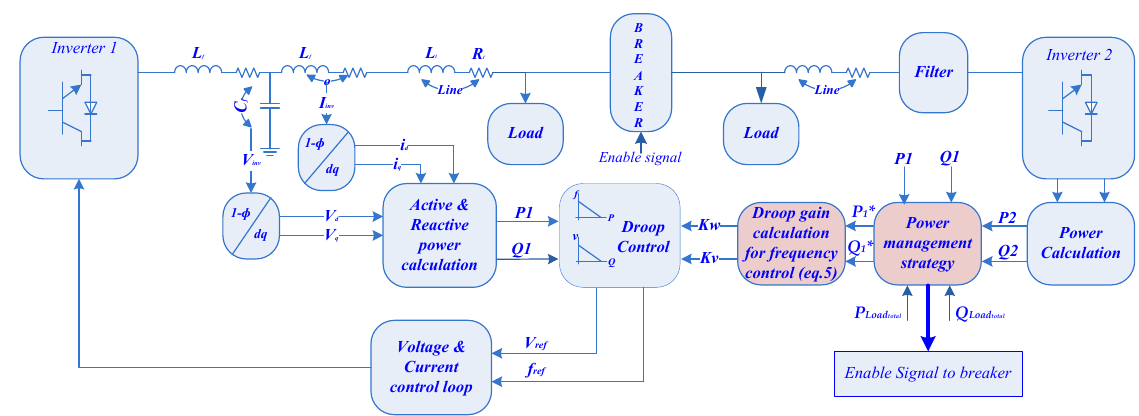
Figure 3. CMG inverter control strategy with incorporation of PM based droop control.